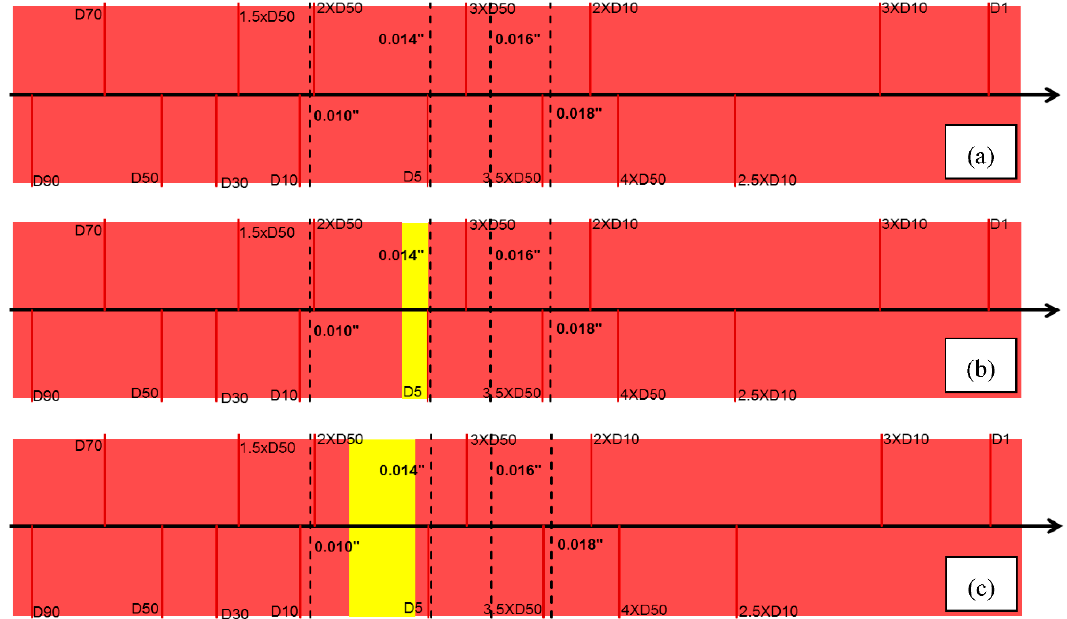
Figure 12. TLS of DC-I in the aggressive condition for SPF 120 ( a ), SPF 168 ( b ), and SPF 216 ( c ).